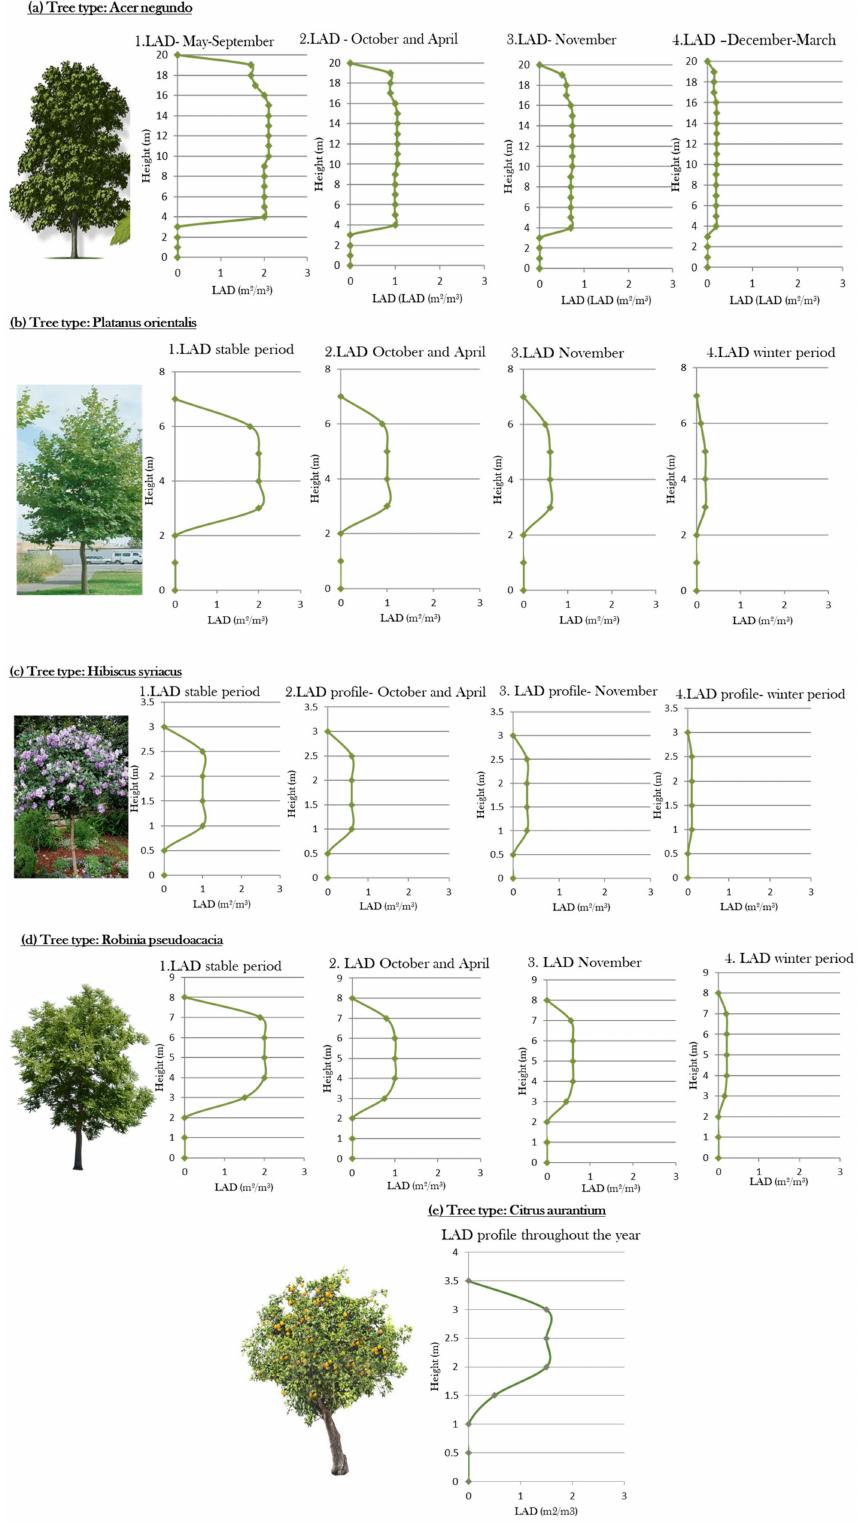
Figure 5. Seasonal variation in the LAD profile for all tree species of the examined areas. To finalize the model set-up, in all four study areas, receptors points were placed at the corresponding field measurements points and also near the façades of the building units so as to evaluate the ENVI-met model. The energy performance of these receptor points will also be assessed. Based on the recommendations of Yang et al. [13], five